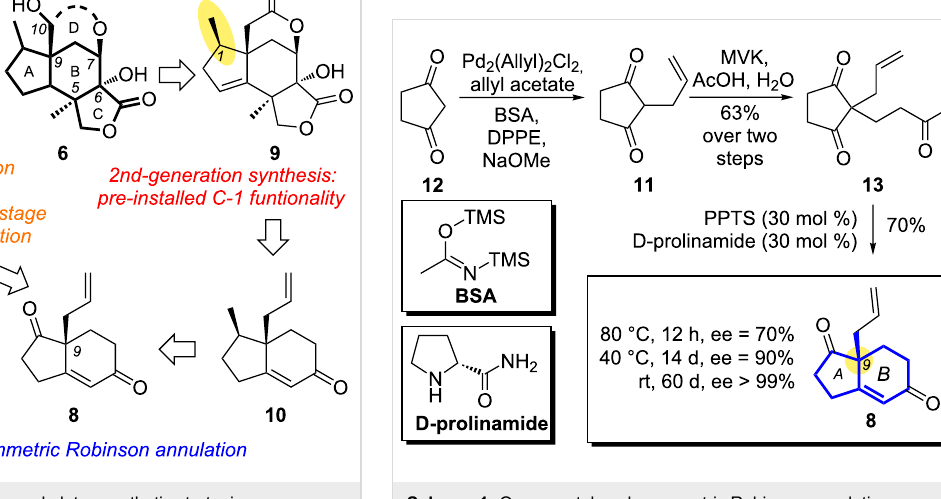
Figure 2: Comparison of core skeleton synthetic strategies. Scheme 1: Organocatalyzed asymmetric Robinson